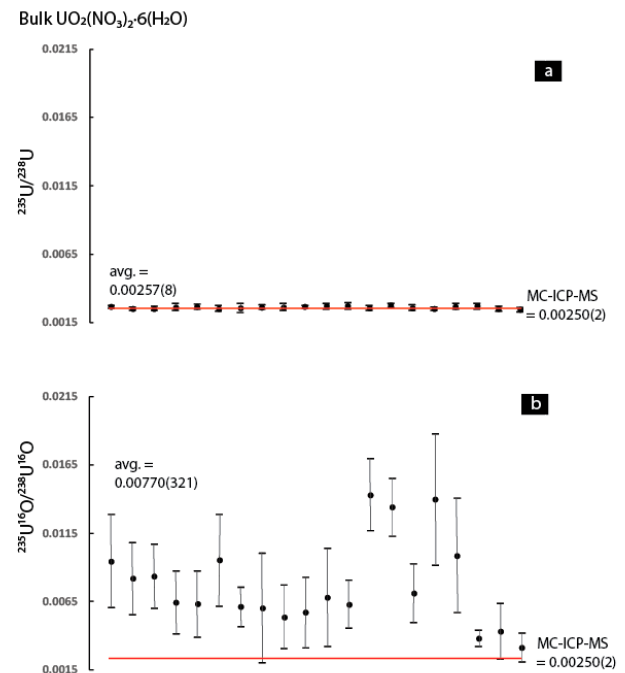
Figure 7. Plot of each analysis’s ( a ) 235 U/ 238 U and ( b ) 235 U 16 O/ 238 U 16 O ratio and its associated 1 σ uncertainty, relative to the solution MC-ICP-MS value (red line), for the UF 4 .